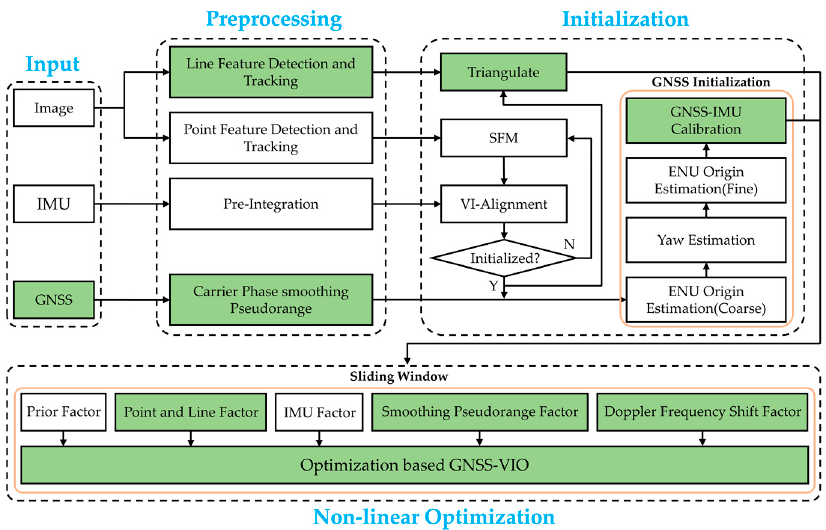
Figure 4. A block diagram illustrating the workflow of our proposed